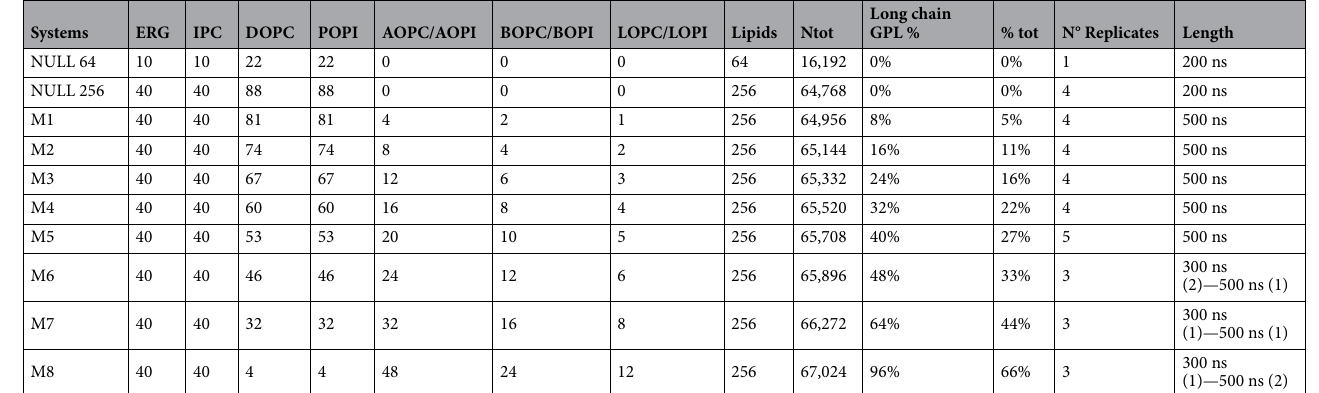
Table 1. Lipid compositions of the yeast membrane systems. Eight lipid membrane systems (represented M1 to M8) with increasing content of different very-long-chain GPLs (8, 16, 24, 32, 40, 48, 64 and 96 mol%) were constructed, starting from two reference yeast membrane models (denoted NULL-64 and NULL-256, see “Materials and methods” section). Long-chain GPLs AOPC and AOPI with the sn1 acyl chain length of 20 carbons, BOPC and BOPI with the sn1 acyl chain length of 22 carbons, LOPC and LOPI with the sn1 acyl chain length of 24 carbons, were introduced at a ratio of 4:2:1, by replacing the representatives of PC and PI lipids (DOPC and POPI, respectively). The same concentrations of sterols and sphingolipids (ERG and IPC, respectively) were maintained in each system as in the reference. The content of very-long-chain GPLs is expressed as a percentage of the total content of GPLs (% GPL, including DOPC, POPI and long-chain GPLs) and the overall number of fatty acid chains (% Tot). The total number of lipid molecules (Lipids) and atoms in each membrane model (N tot ) are also reported. For most of the systems, up to five replicates (No. of replicates) of MD simulations were collected, each of 200–500 ns length. AOPC 1-arachidoyl-2-oleoyl-sn-glycero-3- phosphocholine, AOPI 1-arachidoyl-2-oleoyl-sn-glycero-3-phospho ‐ (1’ ‐ myo ‐ inositol) , BOPC